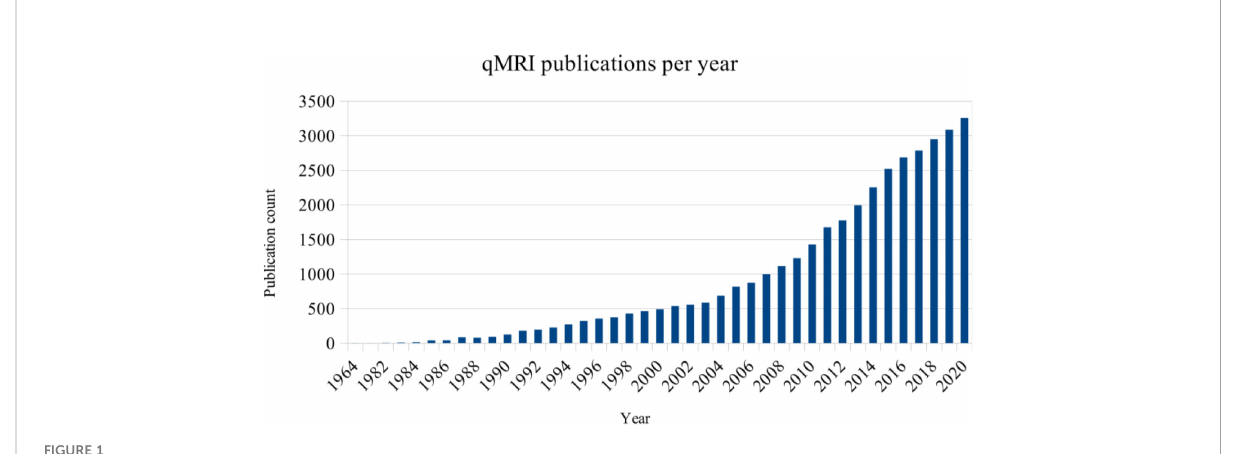
FIGURE 1 Number of entries in PubMed regarding “ quantitative MRI ” , by year of